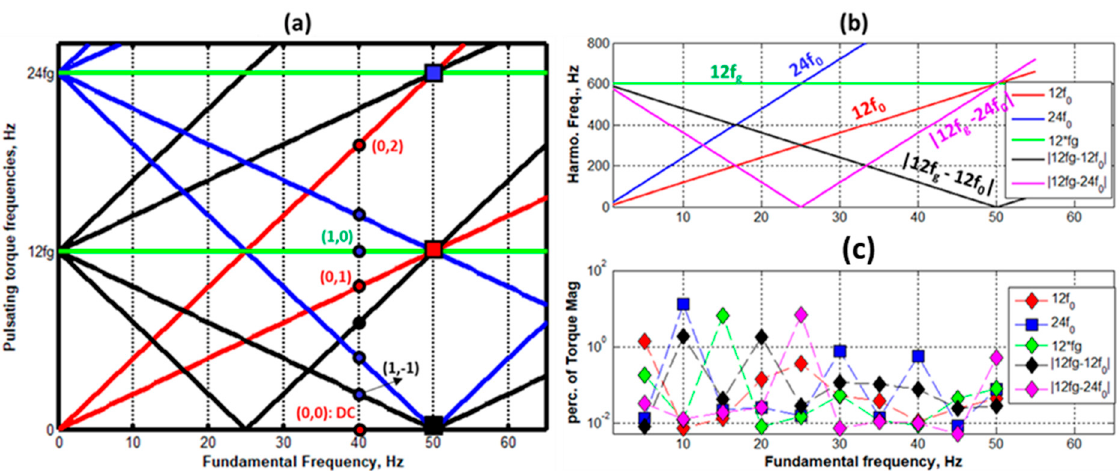
Figure 25. Summary of simulation results of a 12/12-pulse LCI system: ( a ) Campbell diagram with specific parameters ( m , n ) to localize the simulated torque harmonics at 40 Hz, ( b ) relevant air-gap torque harmonic families and ( c ) magnitudes of relevant air-gap torque components for each harmonic family.